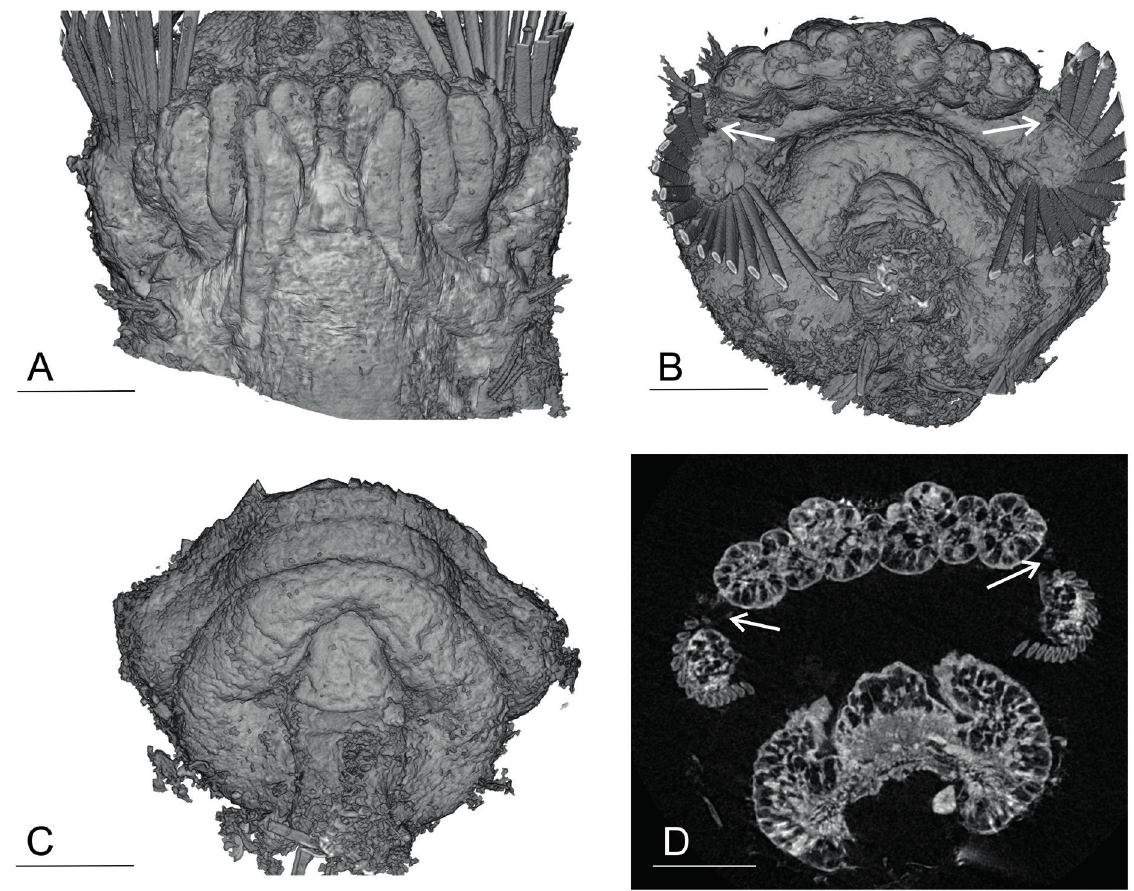
Fig. 5. Anobothrus konstantini Säring & Bick sp. nov., additional material (ZSRO-P2658). Micro-CT graphs, additional material. A . Anterior end with arrangement of branchiae, dorsal view. B . Anterior end with arrangement of branchiae, frontal view (note semicircular arrangement of paleae; arrows: small paleae on each side). C . Frontal view of anterior end, without branchiae or paleae (note: Ampharete -type prostomium). D . Anterior end, transverse section of branchiae, paleae and prostomium (note arrows: small paleae on each side). Scale bars: A–D = 100